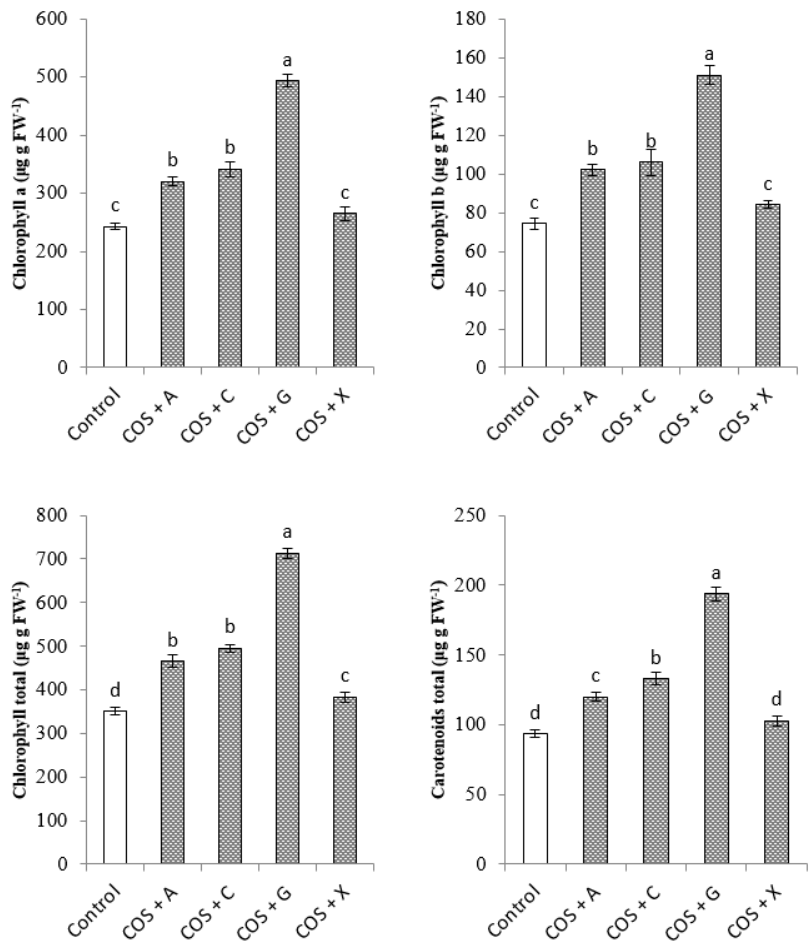
Figure 1. Effects of COS coating combined with selected ionic polymers on chlorophyll and carotenoids content of Ornithogalum saundersiae . Treatments: Non-coated bulbs (Control); COS + alginic acid sodium salt from brown alga (COS + A); COS + carrageenan iota (COS + C); COS + gellan gum (COS + G); COS + xanthan gum (COS + X). All data are means ± standard deviation (vertical bars). The columns with the different letters indicate significant differences ( p ≤ 0.05).